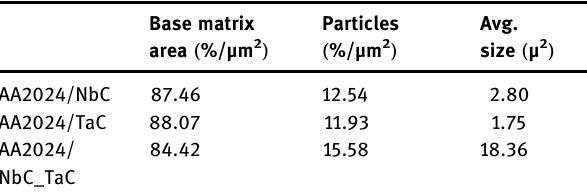
Table 3: The distribution of the percentage of the reinforced parti